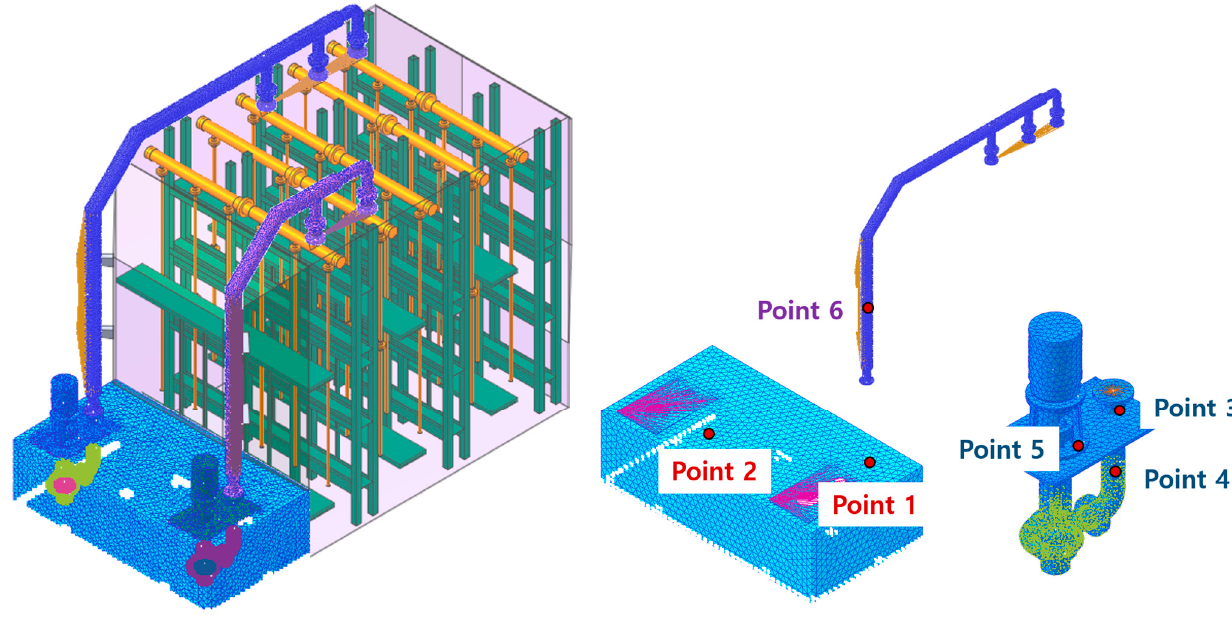
Figure 3. A multi-flexible body and its data points.